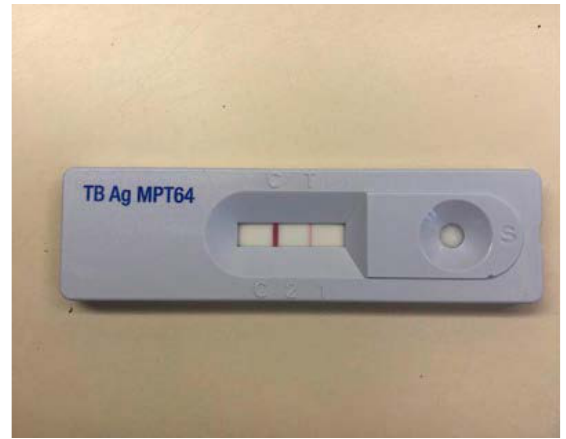
fIguRE 5 – Positive rapid test for M. tuberculosis